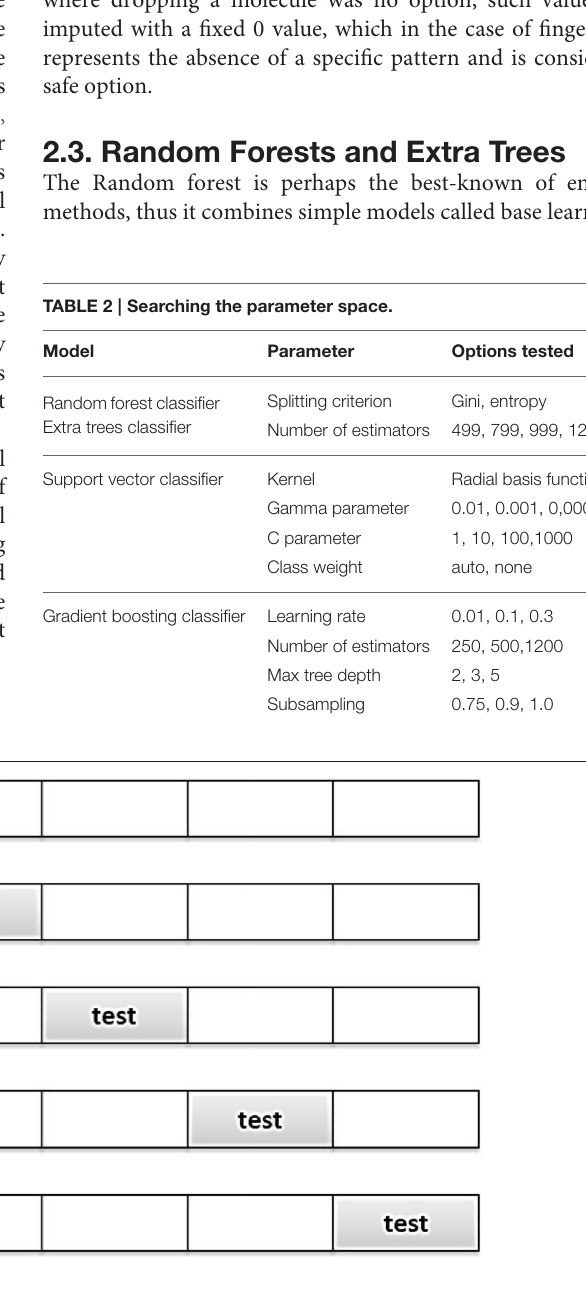
FIGURE 4 | Illustrative example of 5-fold